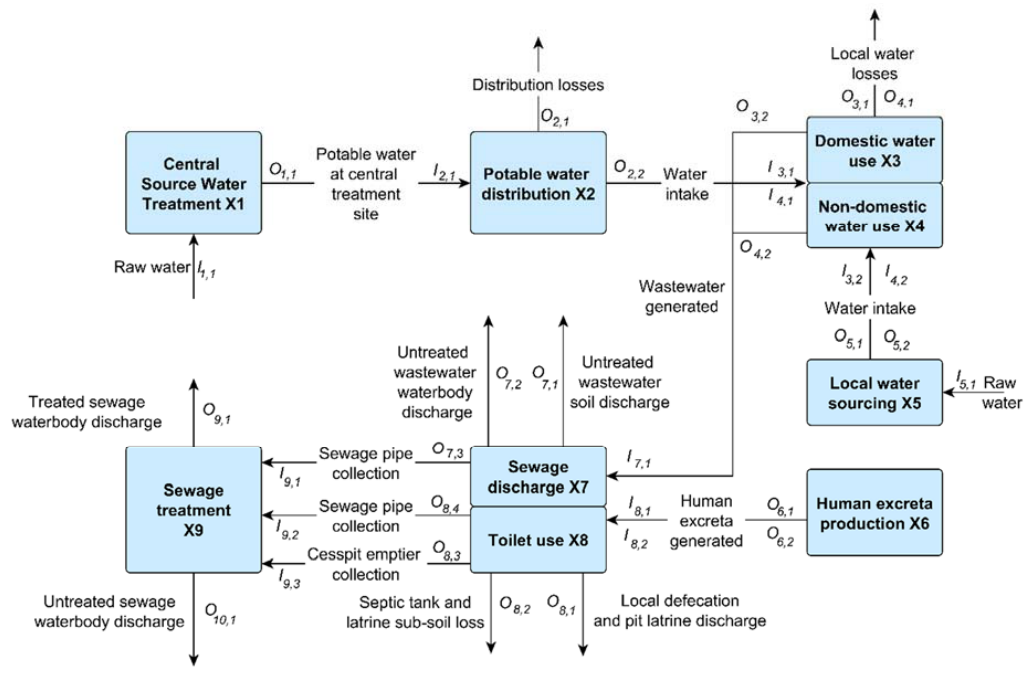
Figure 1. Overview of Water, Sanitation and Hygiene (WASH) flow calculations made in the study using mass-balance principles.